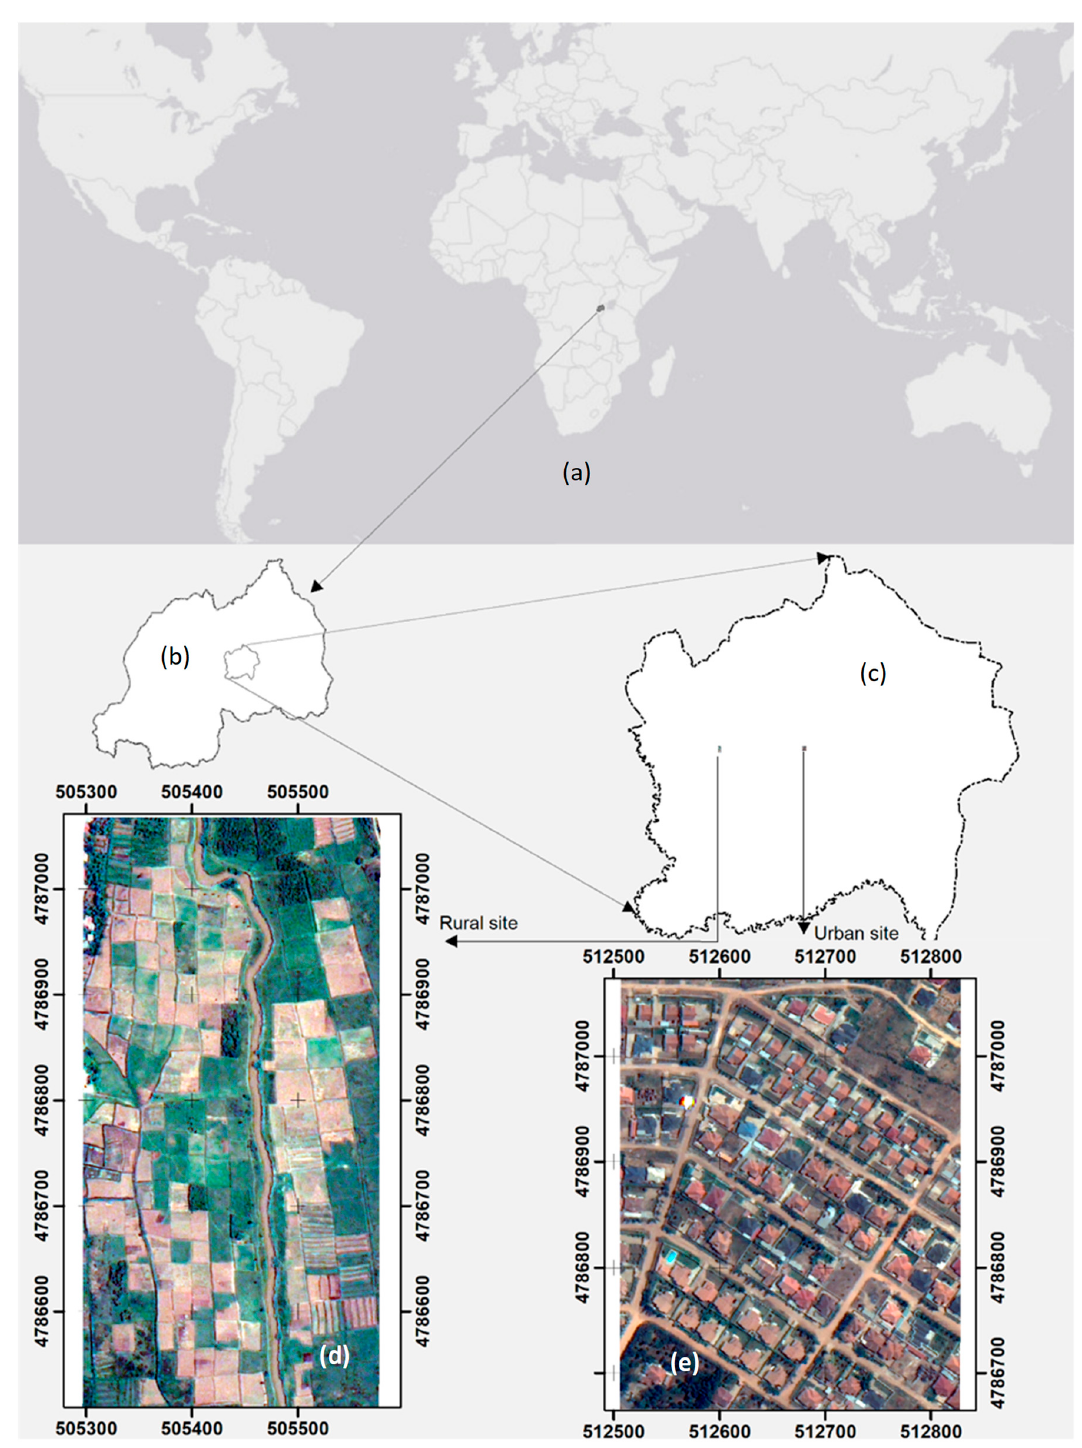
Figure 1. Case study location: ( a – e ) show, respectively, the study area on global scale; Rwanda; the city of Kigali; the rural site and urban site. Coordinates system is ITRF2005.